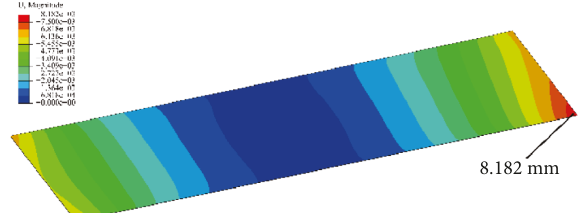
Figure 10: Curing deformation of the panel.